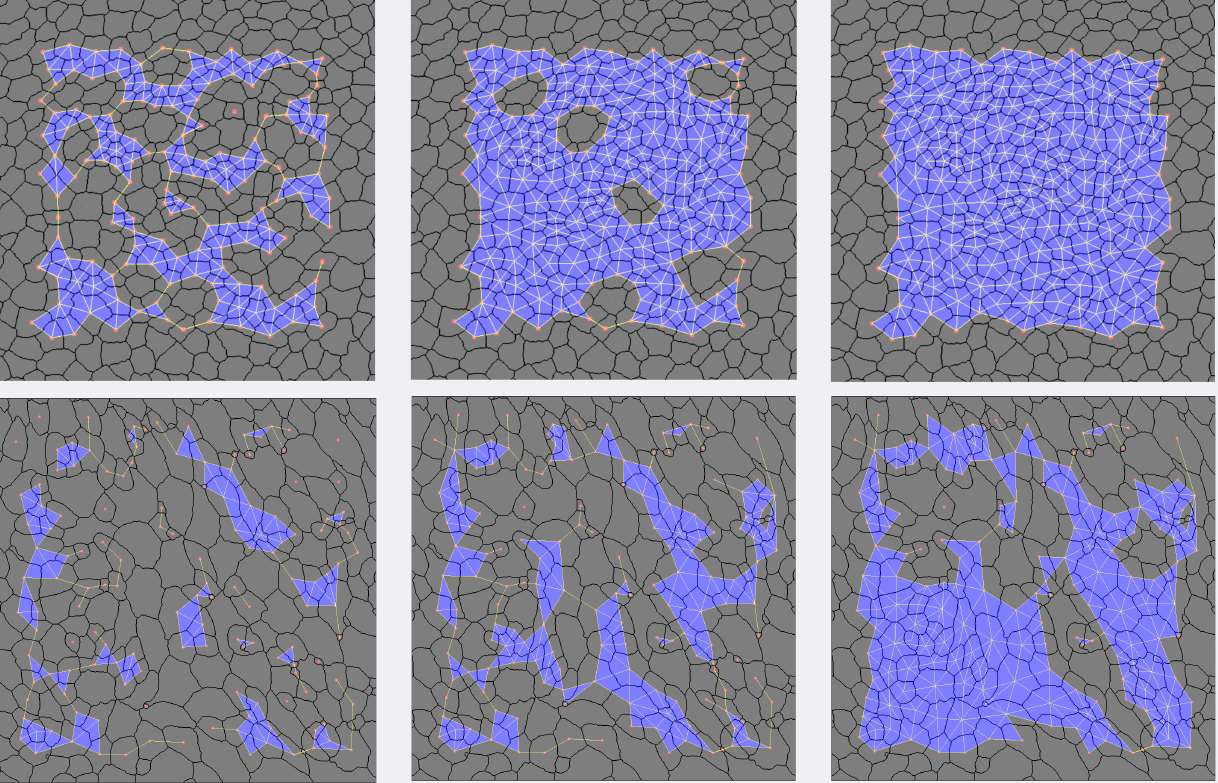
Figure 2. An example of the sub filtration for i = 6, 7, 8. The top row corresponds to dNP and the bottom to